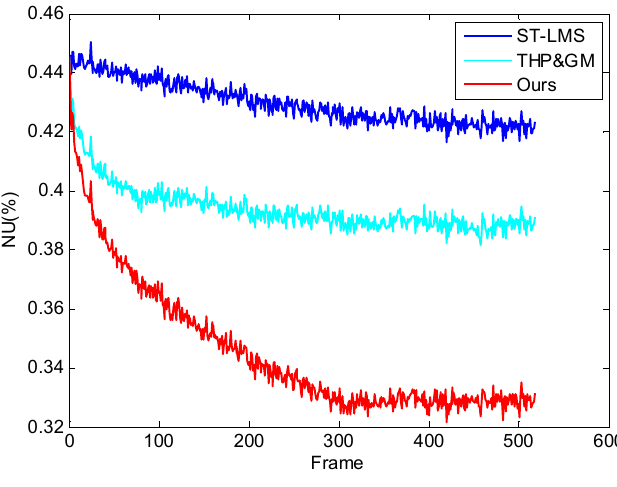
Figure 16. The NU curve of the frames.